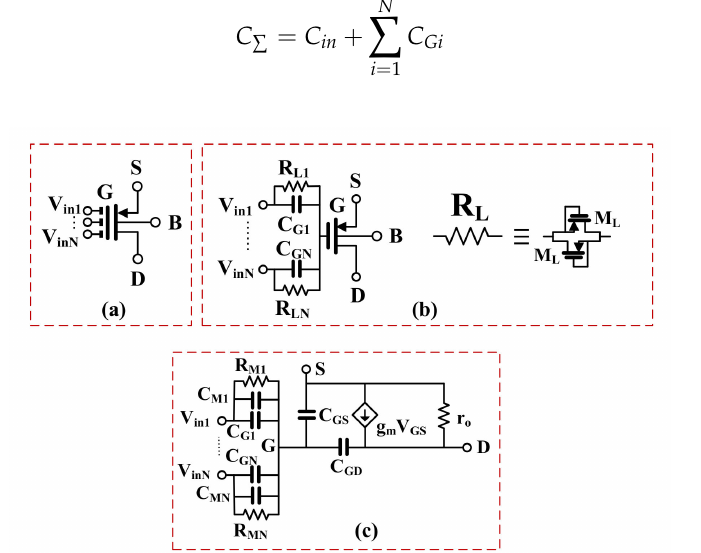
Figure 4. MIGD MOS transistor, ( a ) symbol, ( b ) realization, ( c ) small-signal